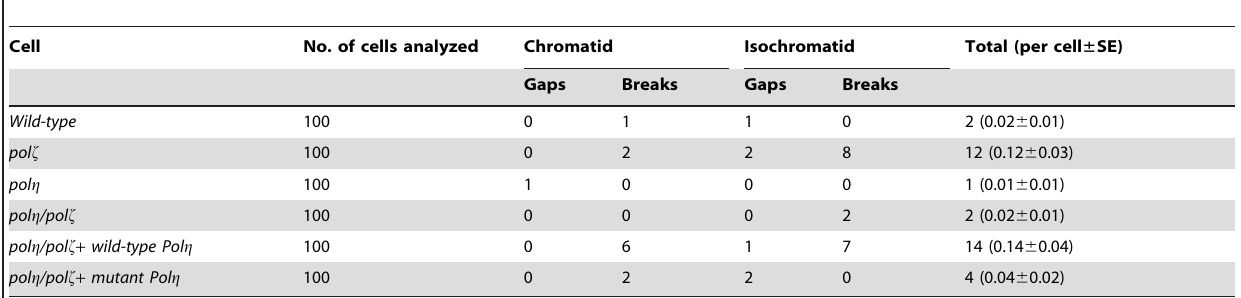
Table 1. Frequency of spontaneous chromosomal aberrations in wild-type , pol f , pol g , and pol g /pol f double mutants.*